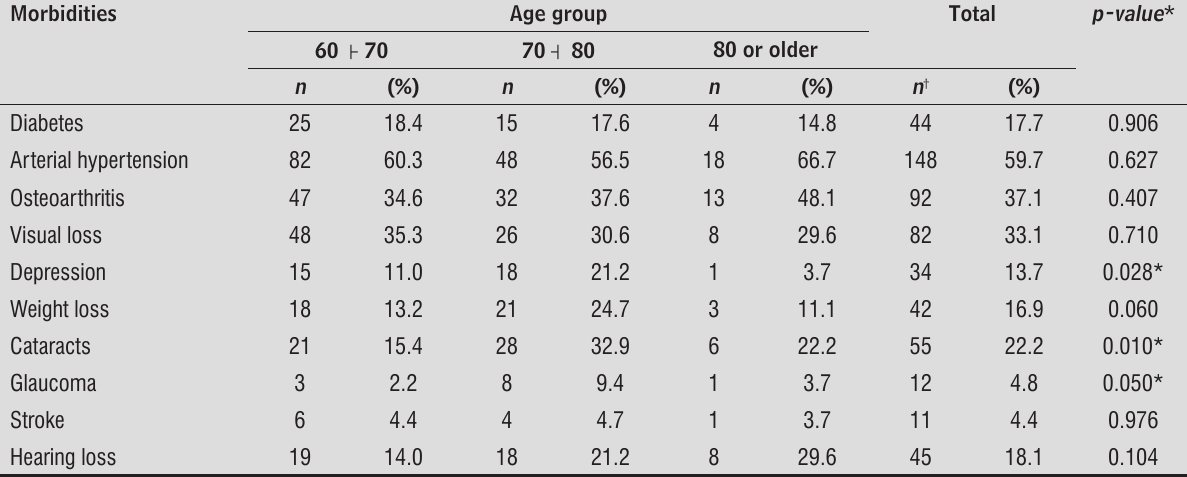
Table 3 - Distribution of self-reported morbidities by age group. Uberaba, MG, Brazil, 2011 Morbidities Age